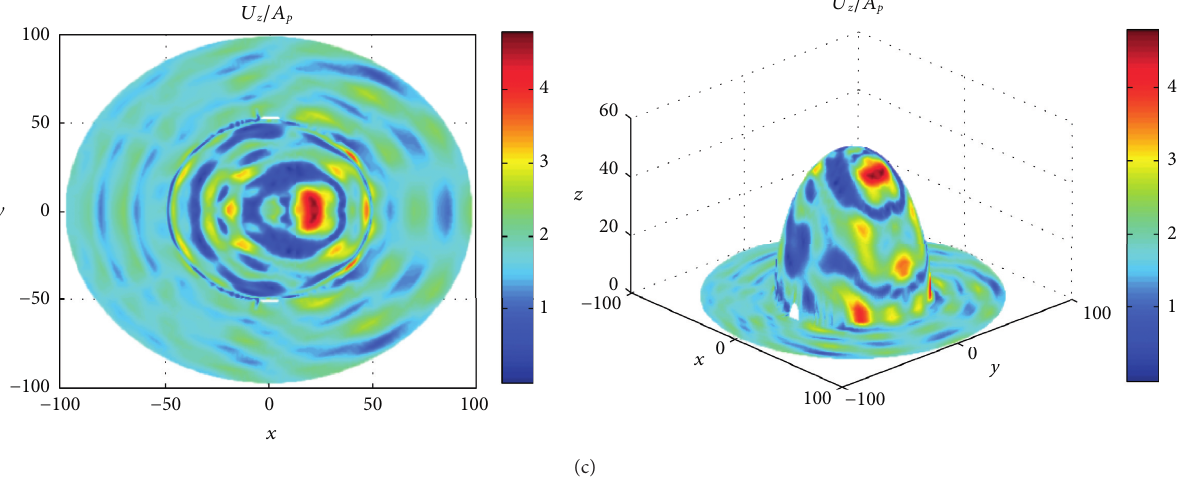
Figure 10: Surface displacement amplitude of the 3D tunnel mountain under the incident P wave ( η � 5 . 0 , α � 30 ° ): (a) surface dis- placement amplitude in x direction; (b) surface displacement amplitude in y direction; (c) surface displacement amplitude in z